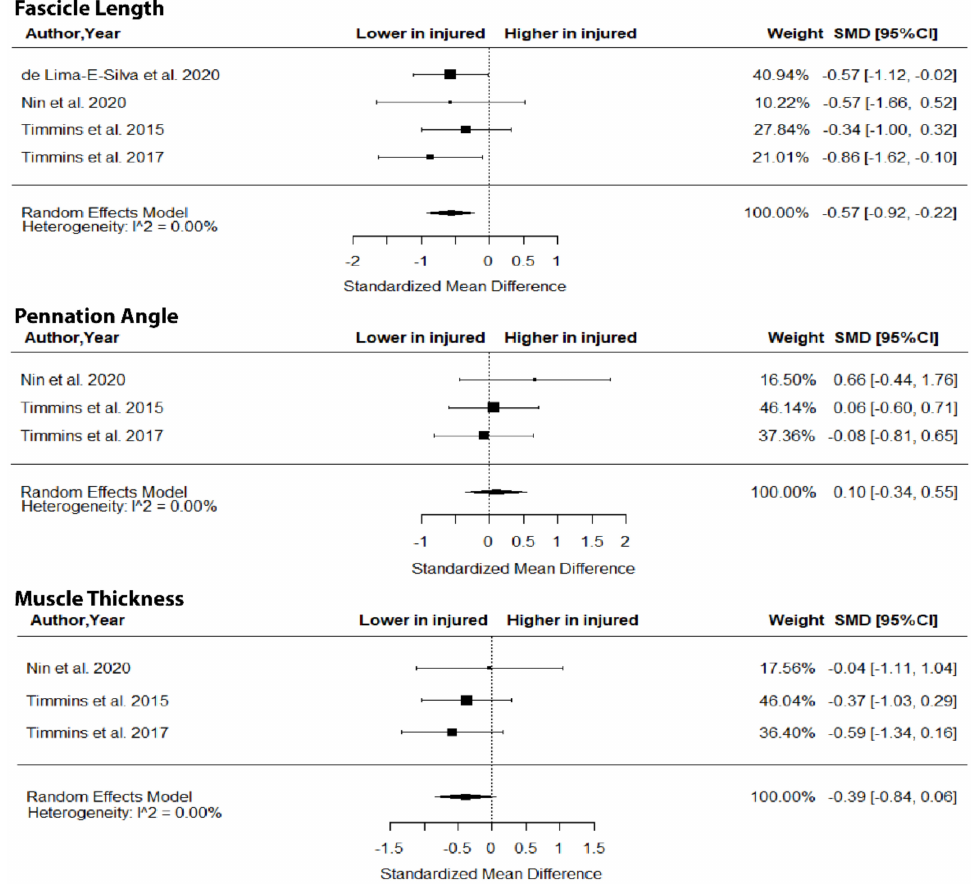
Figure 5. Forest plot of differences in fascicle length, pennation angle and muscle thickness of biceps femoris long head between individuals with a previous hamstring strain and controls.